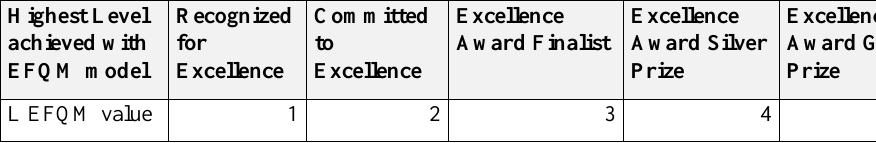
Table 3 – L EFQM variable values (ordinal variable)